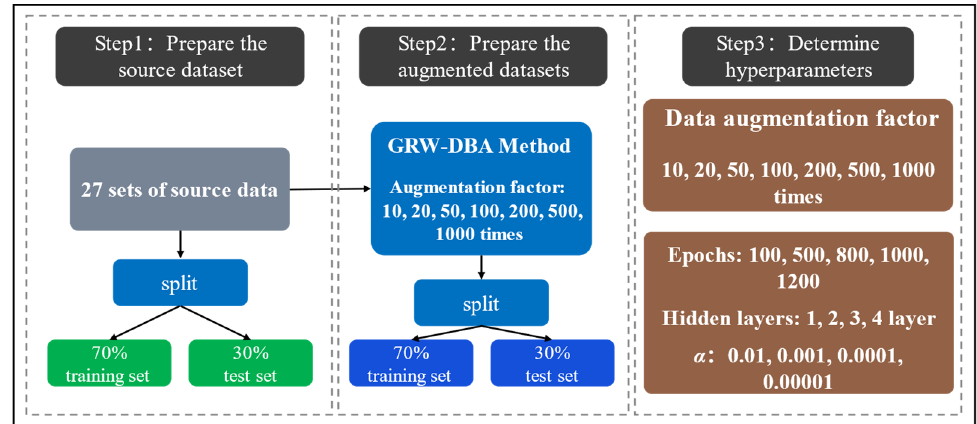
Figure 3. Schematic diagram of the modeling process of the prediction model based on GRW-DBA and ANN.